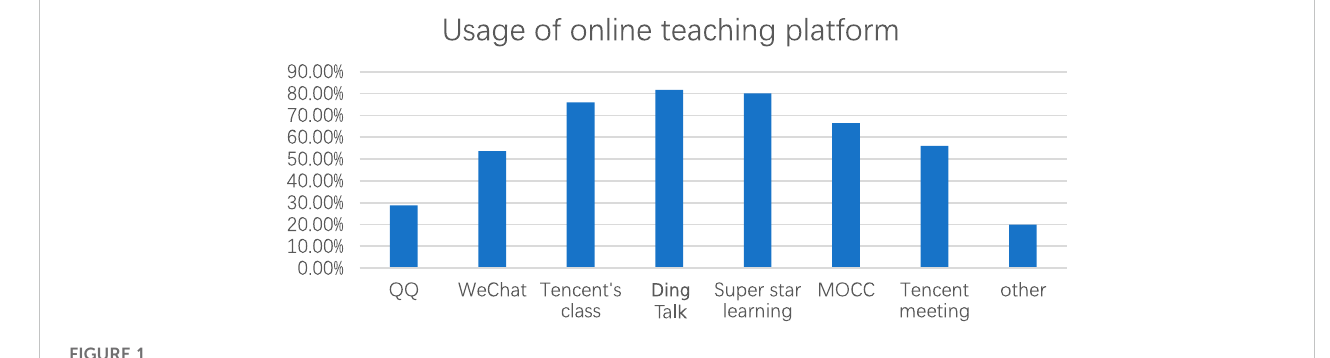
FIGURE 1 Usage of online teaching platforms (data source: online teaching satisfaction questionnaire for college